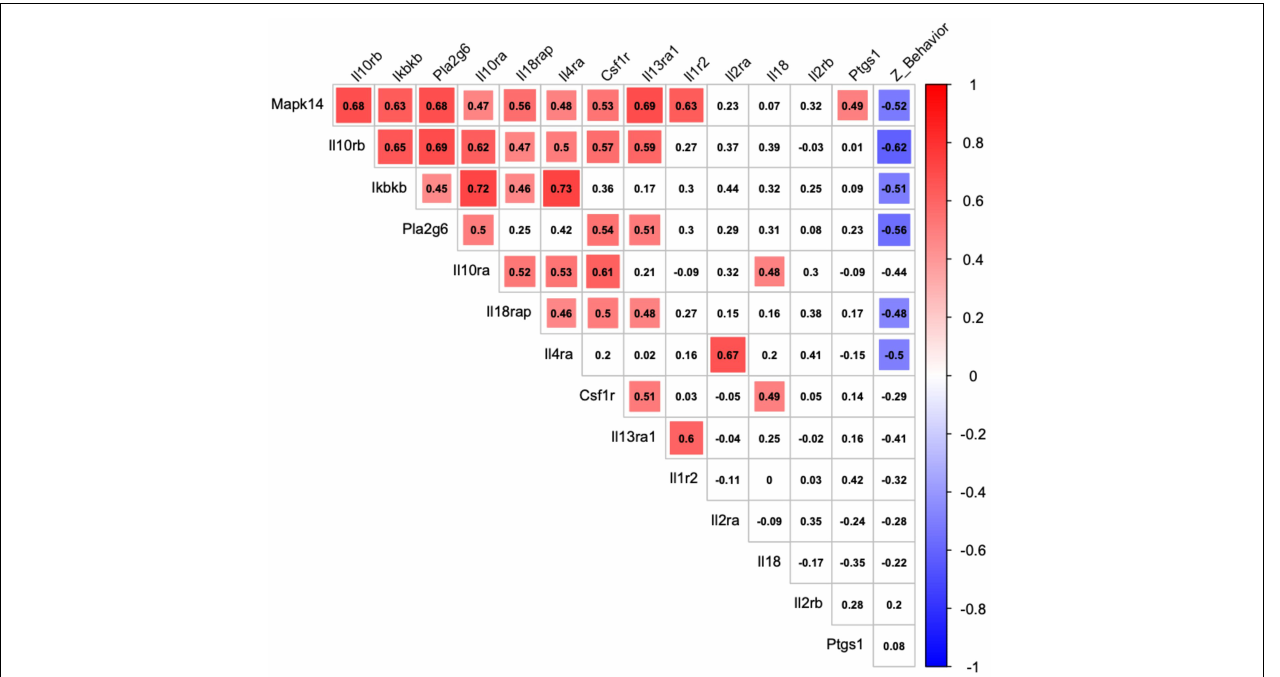
FIGURE 4 | Correlation between transcriptional expression of HRRI candidate genes and depressive-like behavior in adolescent mice. Correlation matrix graph, correlogram, highlighting correlation between qualitative ( Z _Behavior, a depression-index reflecting a composite score of anhedonia and anxiety subscores) and quantitative (transcriptional relative level of HRRI candidate genes obtained by RT-qPCR from blood samples) variables in adolescent mice. The variables are ordered according to first principal components. Positive correlations are displayed in red and negative correlations in blue color. The intensity of the color and the size of the squares are proportional to the Pearson correlation coefficients. Only significant correlations are indicated by a colored